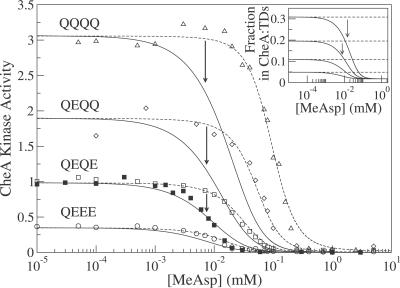
From Signaling to Assembly KineticsDifference between the equilibrium partition of receptors incubated without MeAsp (dashed curves) or with MeAsp (solid curves), using the equilibrium-assembly model. Dashed curves and data (open symbols) are from Figure 1. Experimentally, the kinetics of complex assembly can be obtained from the ratio of relaxation from the dashed curves to the solid curves following addition of MeAsp (arrows). Also shown is data for Tar{QEQE} receptors from in vitro activity assays of Lai et al. [15] (solid squares), based on addition of MeAsp during incubation, but using different protein concentrations compared with Bornhorst and Falke [13]. Inset. fraction of receptors in CheA-bound trimers of dimers (CheA:TDs).